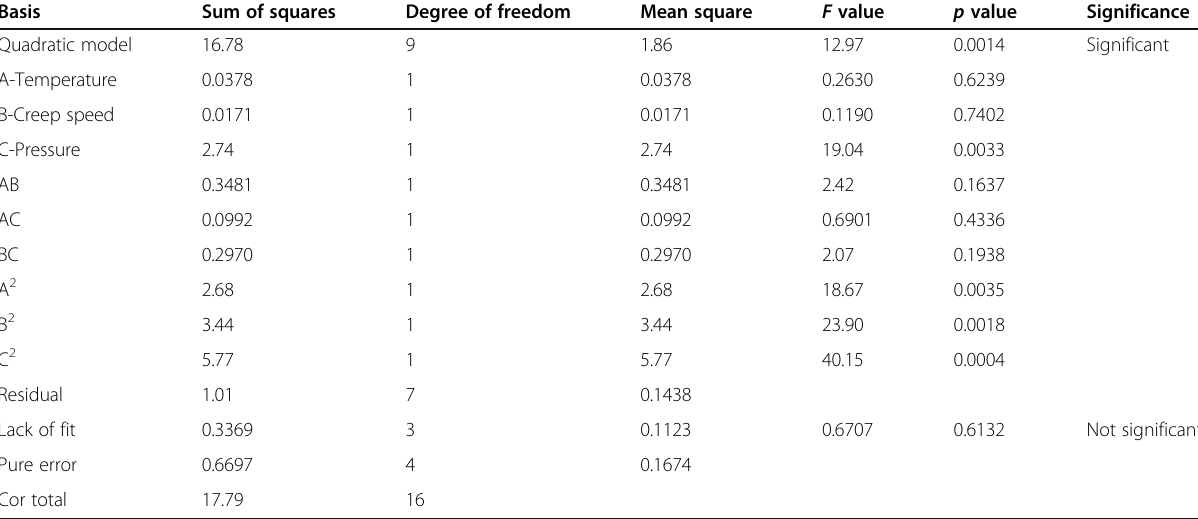
Table 3 ANOVA for quadratic model. Response 1: yield